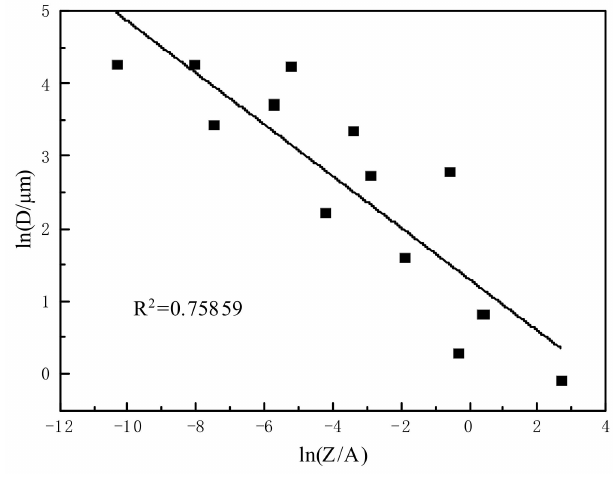
Figure 9. The relationship between the DRX grain size D and the parameters Z and A.